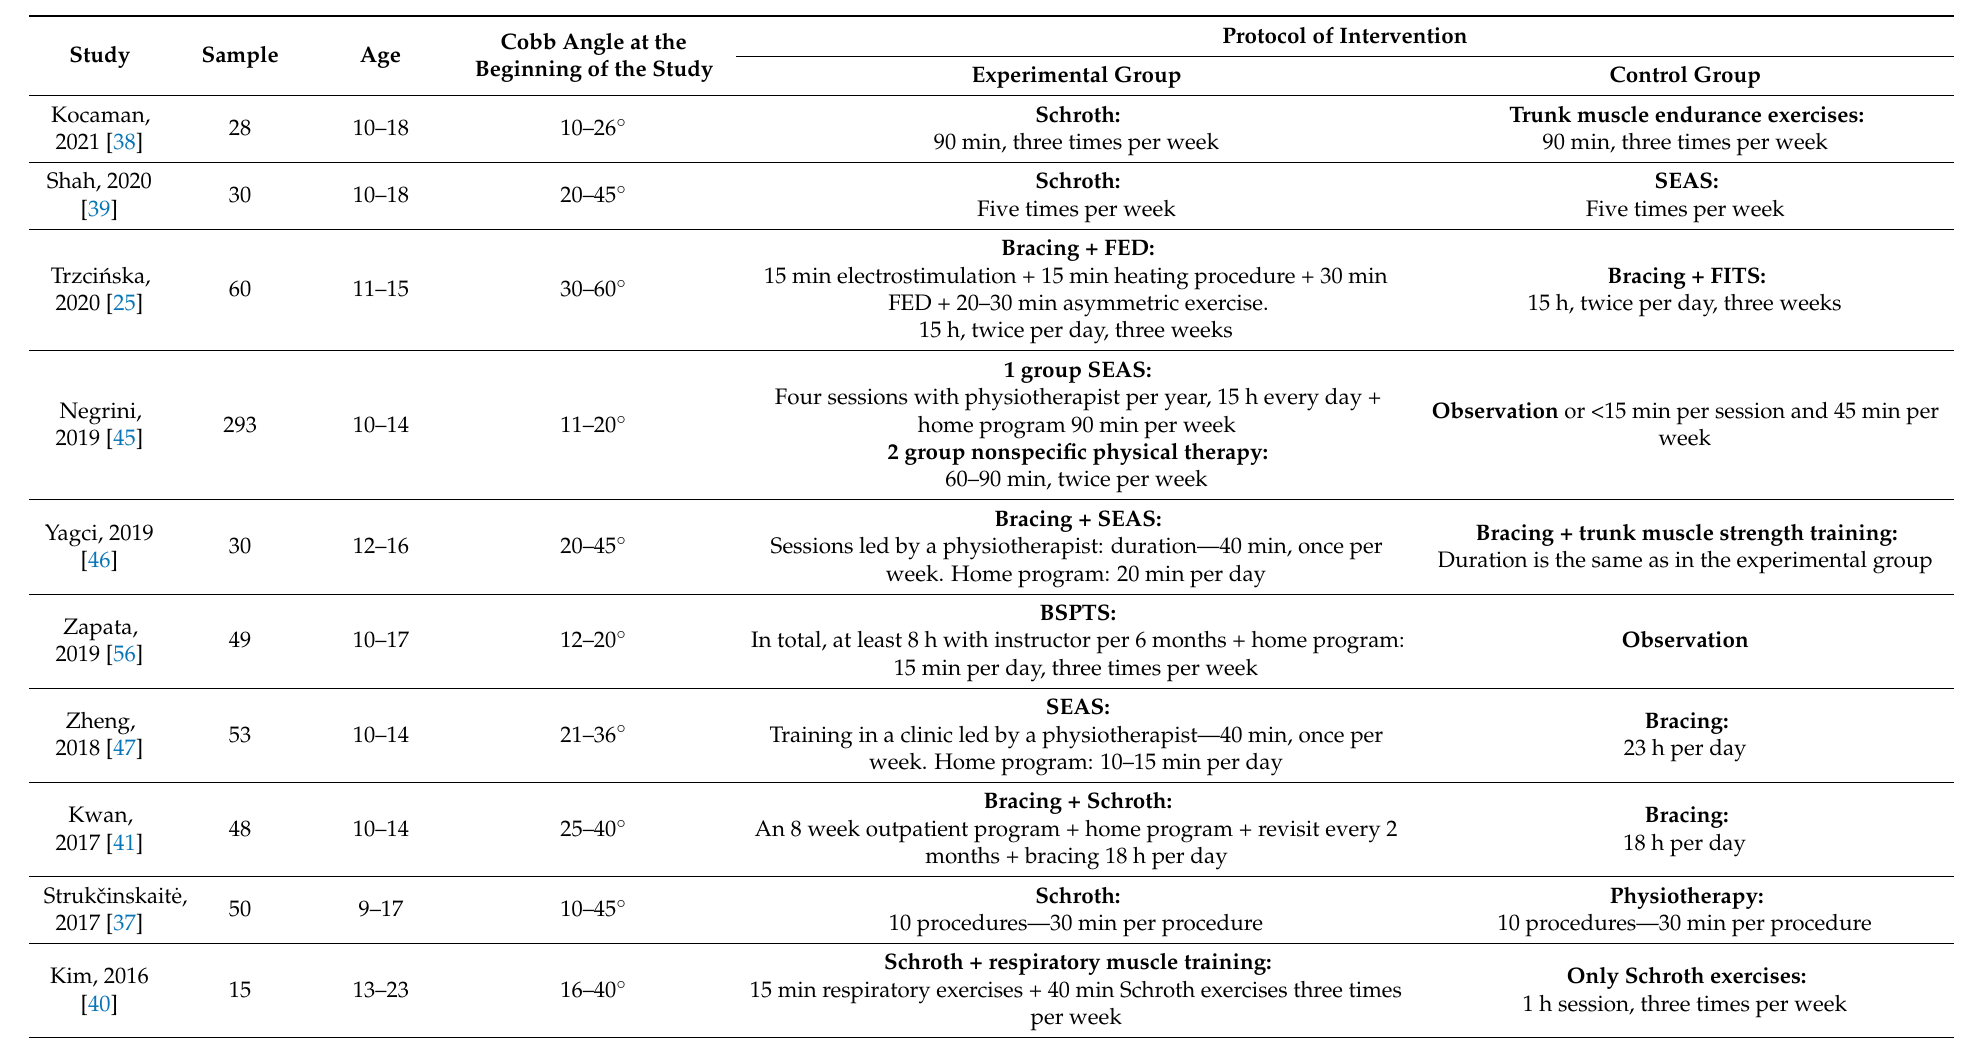
Table 2. Characteristics of controlled clinical trials performed in